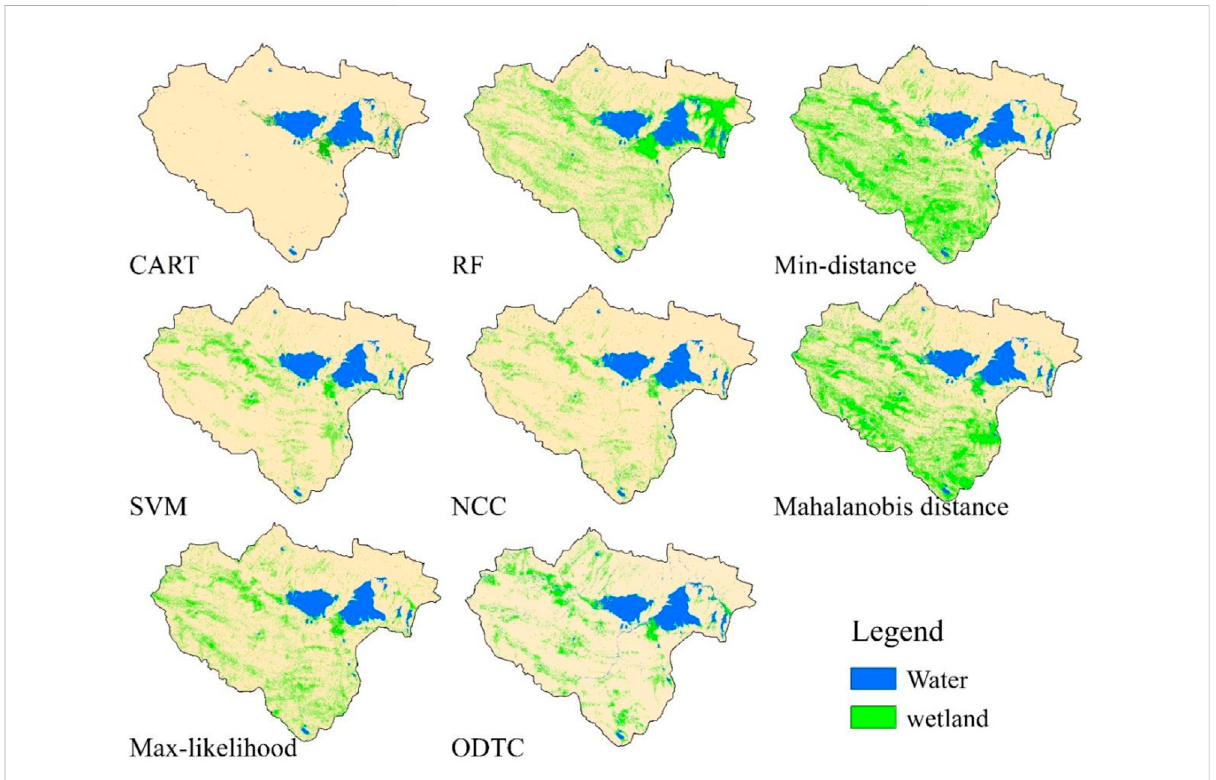
The comparison of the eight classi fi cation